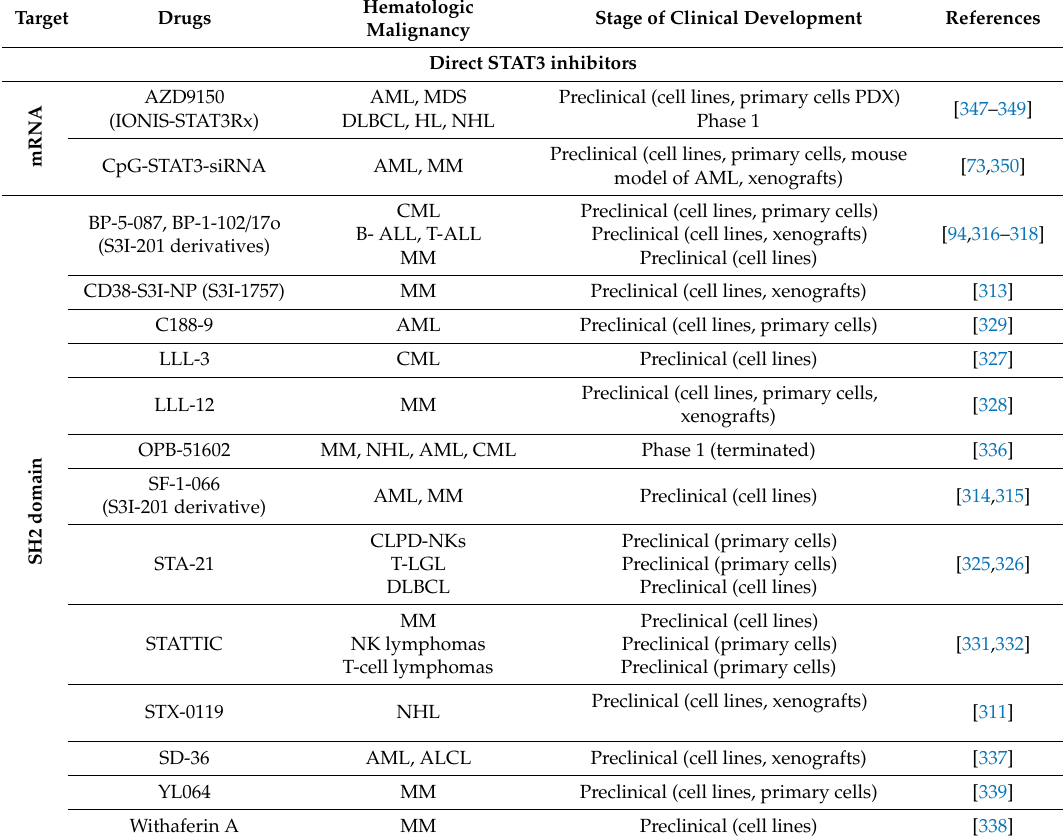
Table 3. Direct inhibitors of STAT3 and STAT5 that have been tested in hematologic